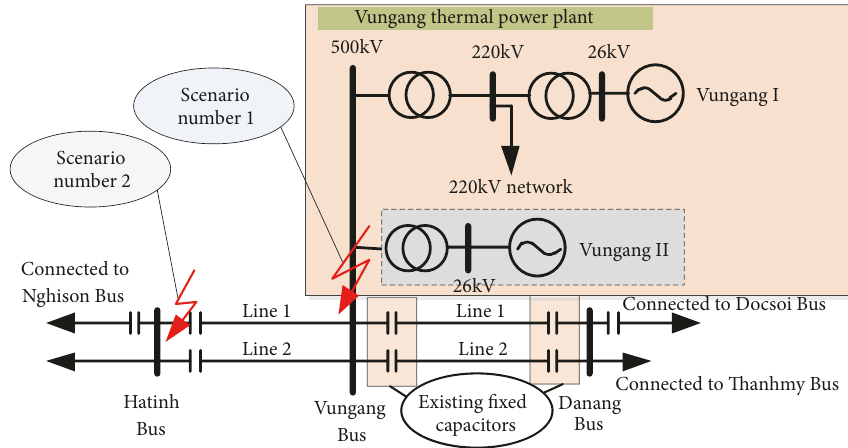
Figure 5: Connected circuit diagram of Vungang plants with 500kV power system model.